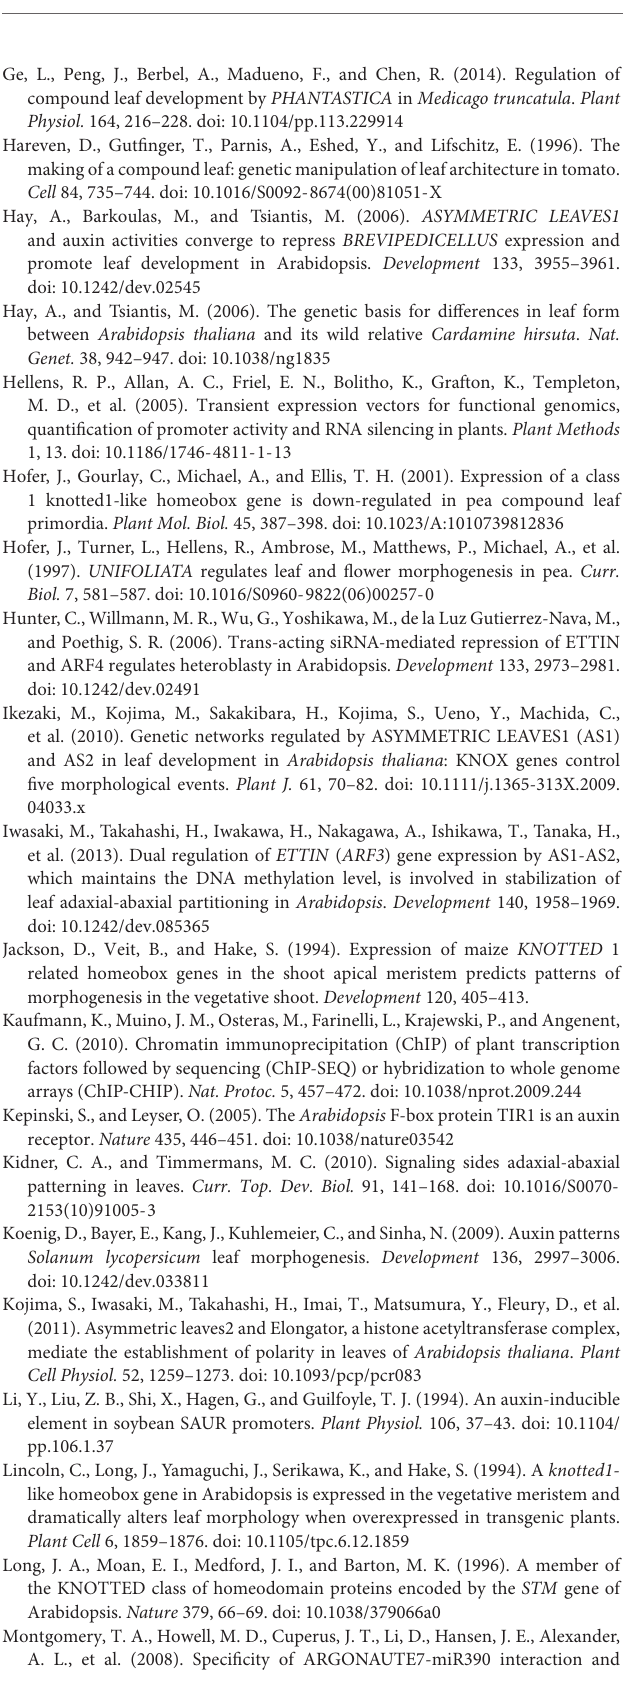
Frontiers in Plant Science |